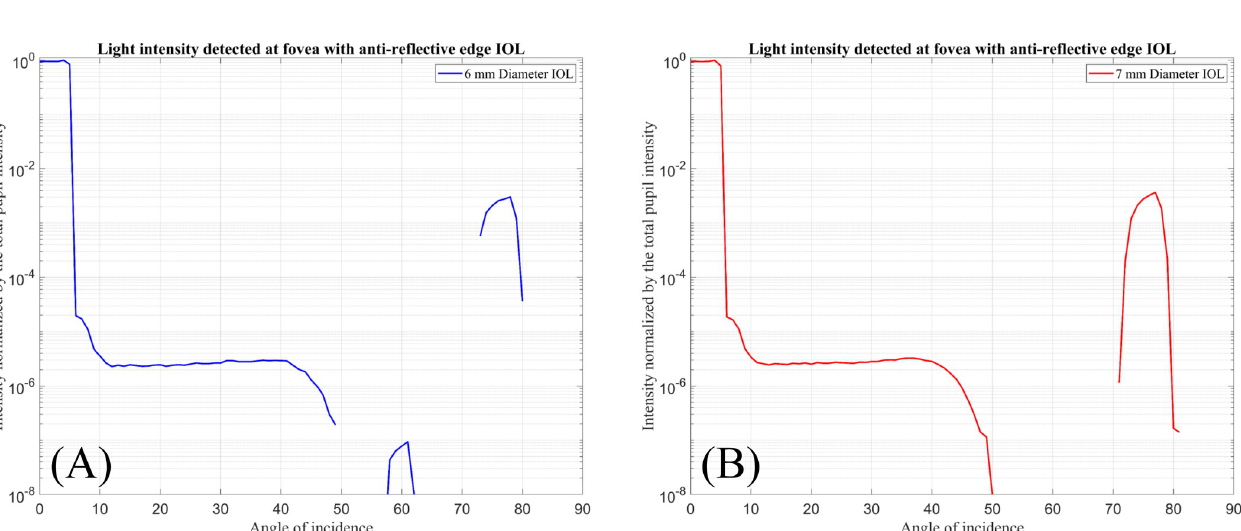
PLOS ONE | https://doi.org/10.1371/journal.pone.0272705 August 5,